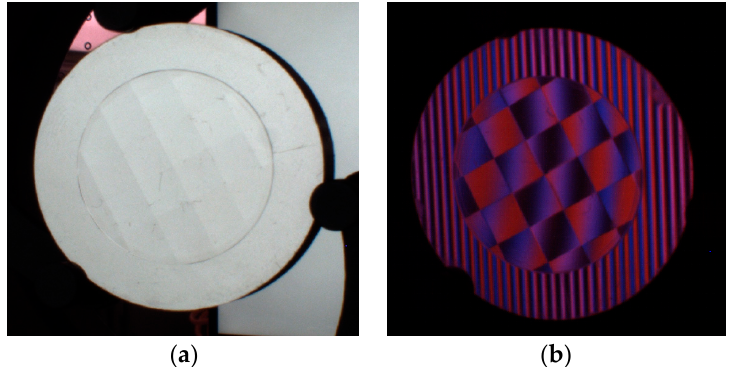
Figure 9. The reflected diamond distribution surface object. ( a ) The photo of the object; ( b ) image of the fringe pattern reflected by the diamond distribution surface object. Sensors 2018 , 18 , 144